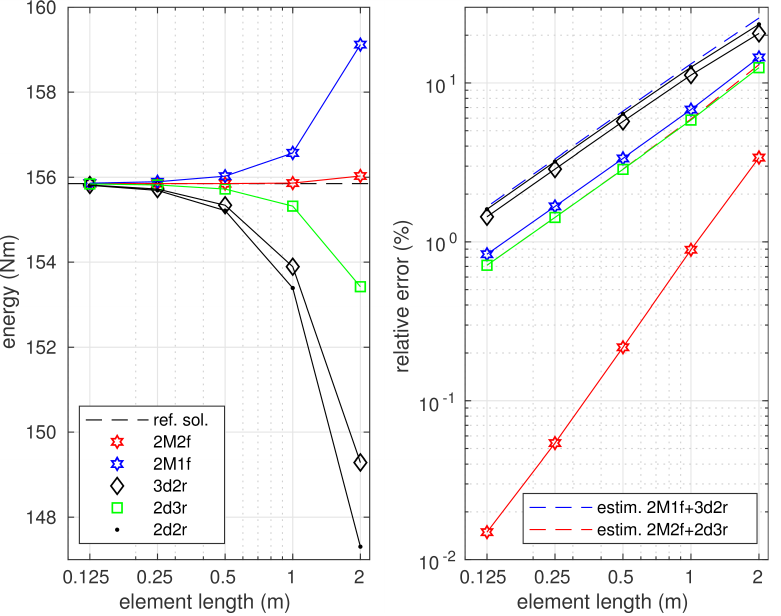
Figure 16. The strain energy and the errors of the approximate solutions in relations with the element length; K s = 0.2 · 10 9